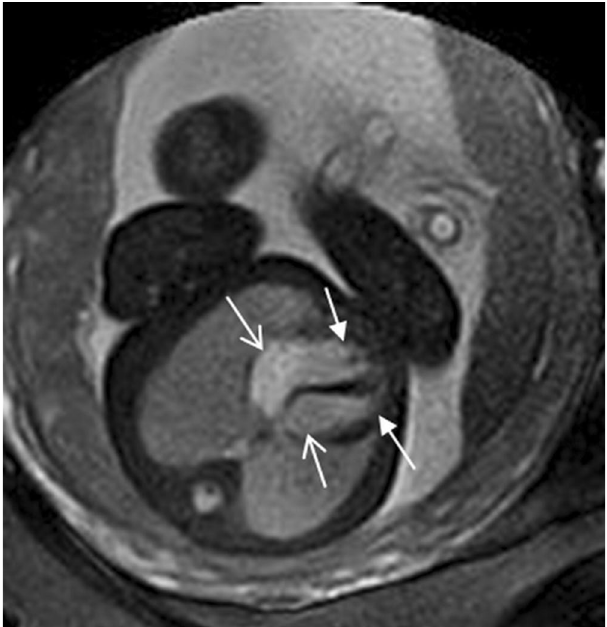
Figure 2. A 26-week-old foetus with a B-TFE sequence with radial k-space sampling. A foetal CMR B-TFE sequence with radial k-space sampling four-chamber view clearly showing a round FOV and the two ventricles (arrows) and two atriums (open